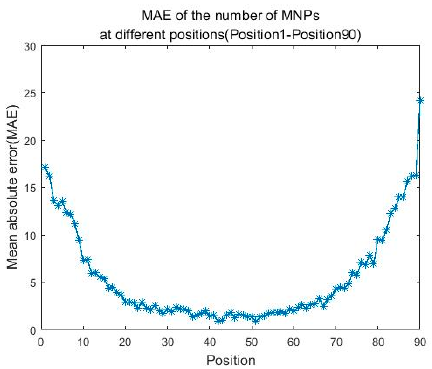
Figure 12. Mean absolute error (MAE) of the number of MNPs at Position1–Position90.